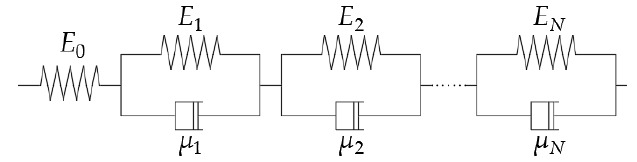
Figure 1. Generalized Kelvin ‒ Voigt model.